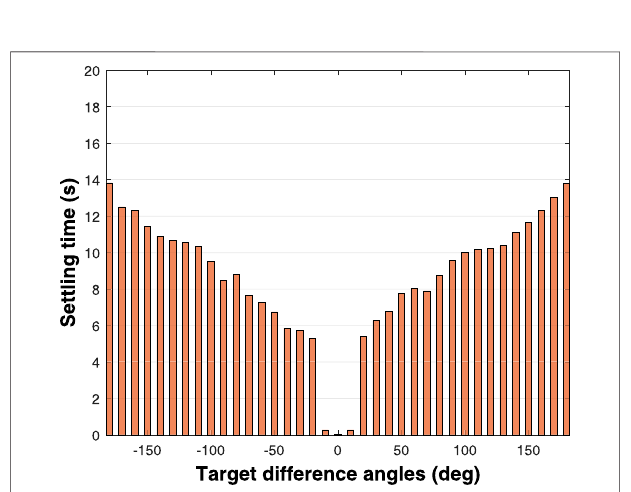
FIGURE 9 | Simulated result of the steady state errors in yaw control of the soft robotic fi sh initially oriented at zero degrees and targeted to swim at everyanglespacedby10degreesintherange( − 180 ° ,180 ° ),whereerrorbars represent the steady state boundaries caused due to the fl apping